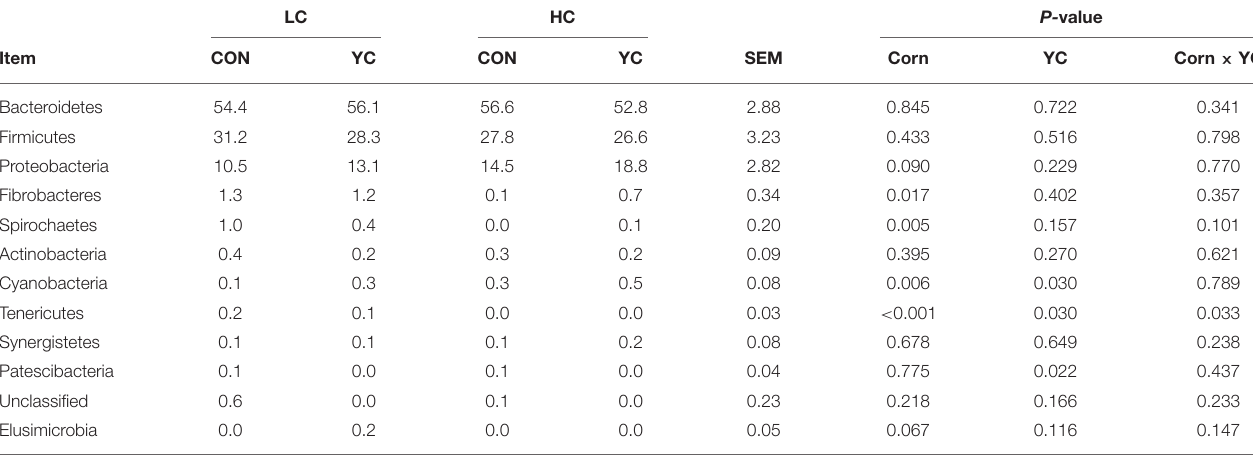
TABLE 8 | Ruminal bacterial phyla (being higher than 0.1% of the total bacteria at least in one of the four treatments) in fattening lambs fed experimental diets containing a low (LC) or high (HC) proportion of corn and supplemented with nil (CON) or yeast culture (YC) ( n = 12 per treatment), expressed as a percentage of the total.